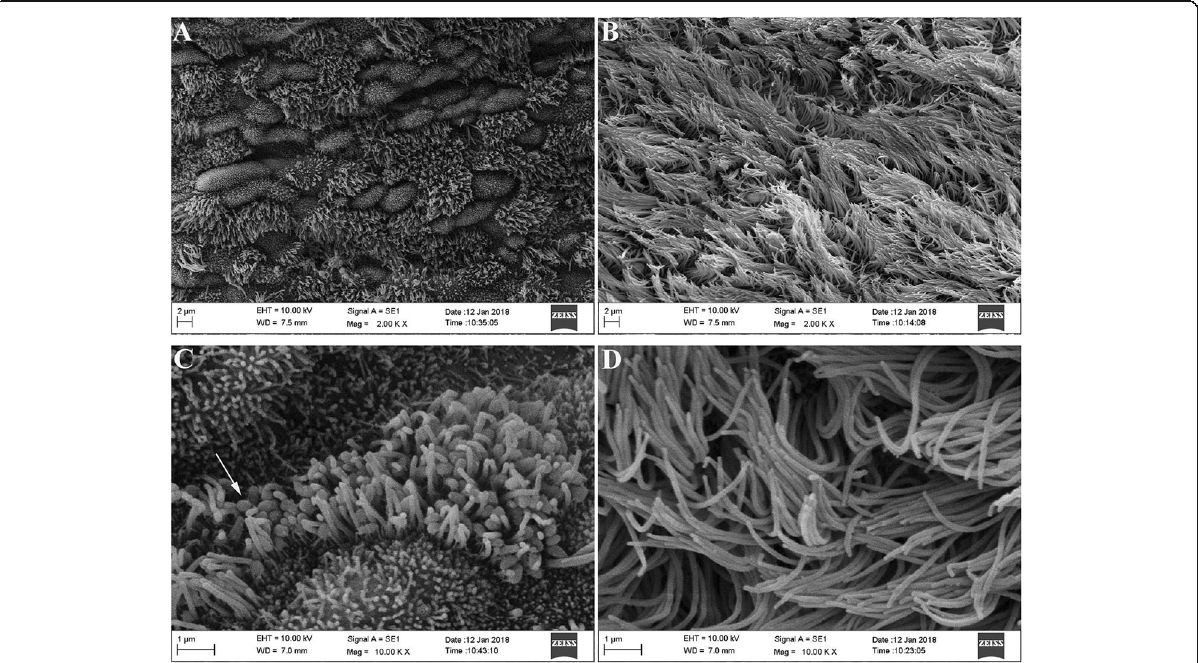
Fig. 3 Scanning electron microscope observation of bronchi ciliary structure. Lungs containing bronchi of all pigs were removed for gross lesion observation and sample collection. a and c represent cilia observations of bronchi samples taken from Bama miniature pigs infected with the M. hyopneumoniae strain JS at 2000 and 10,000 × magnifications, respectively. Elliptical erythrocyte-like forms of M. hyopneumoniae are marked by white arrows on the truncated cilia ( c ). b and d represent cilia observations of bronchi samples taken from Bama mininature pigs in the control group at 2000 and 10,000 × magnifications,